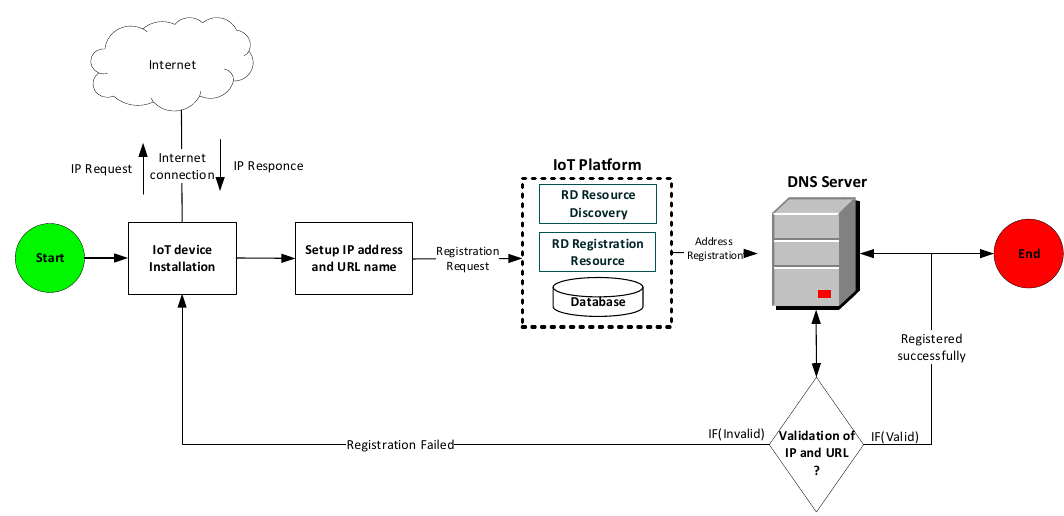
Figure 5. IoT device registration process flowchart of the proposed approach. Electronics 2019 , 8 , x FOR PEER REVIEW